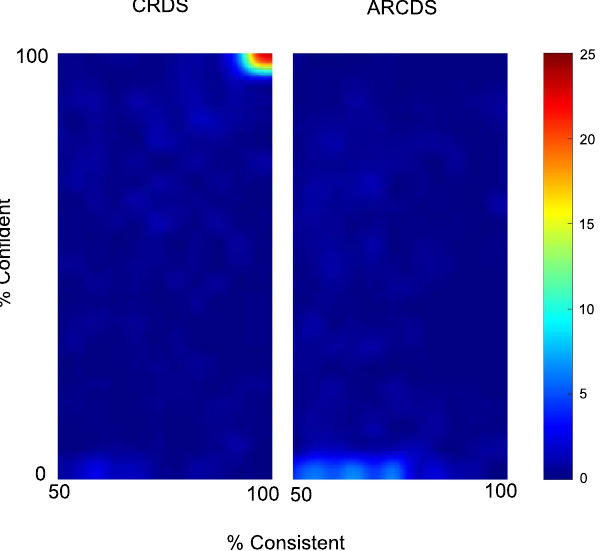
Figure 10. Relationship between consistency of, and confidence in, responses, for CRDS (left) and ACRDS (right). Colour indicates the percentage of responses, for each trial, at each level of consistency and confidence, averaged across all participants and stimuli. High levels of both consistency and confidence were recorded for CRDS, and low levels of both measures for ACRDS.